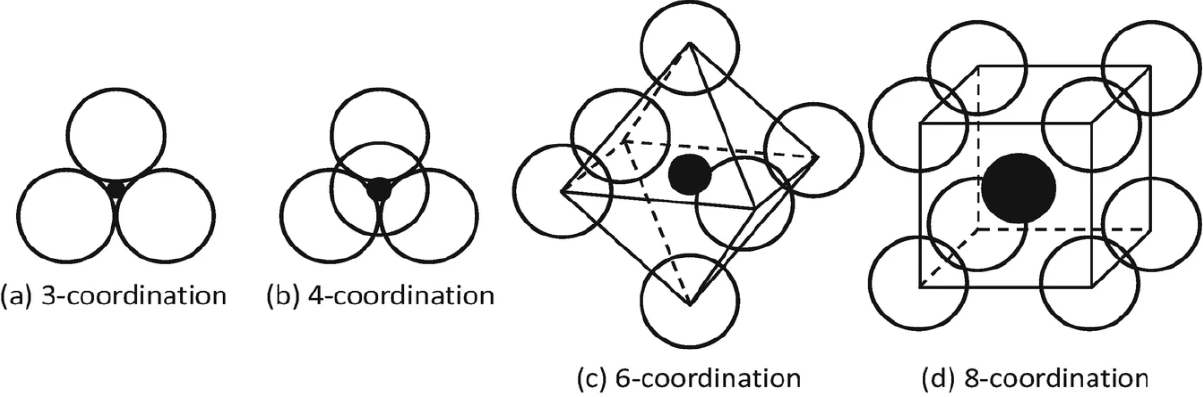
Figure 2. Coordination configuration of different ionic crystals.